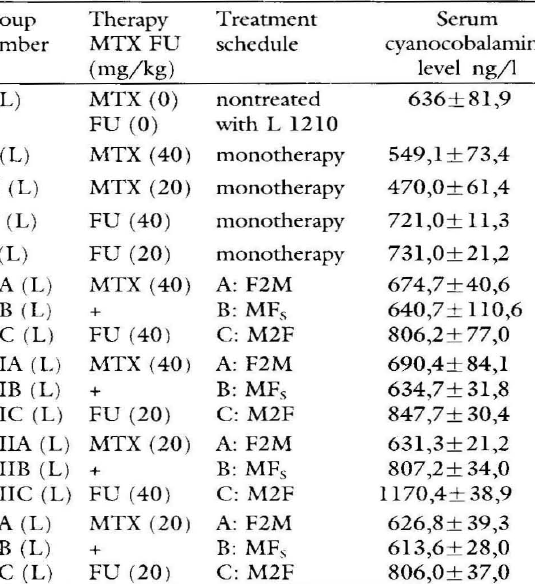
Group symbols as in Table 3. Significance level set at p<:::; 0.05